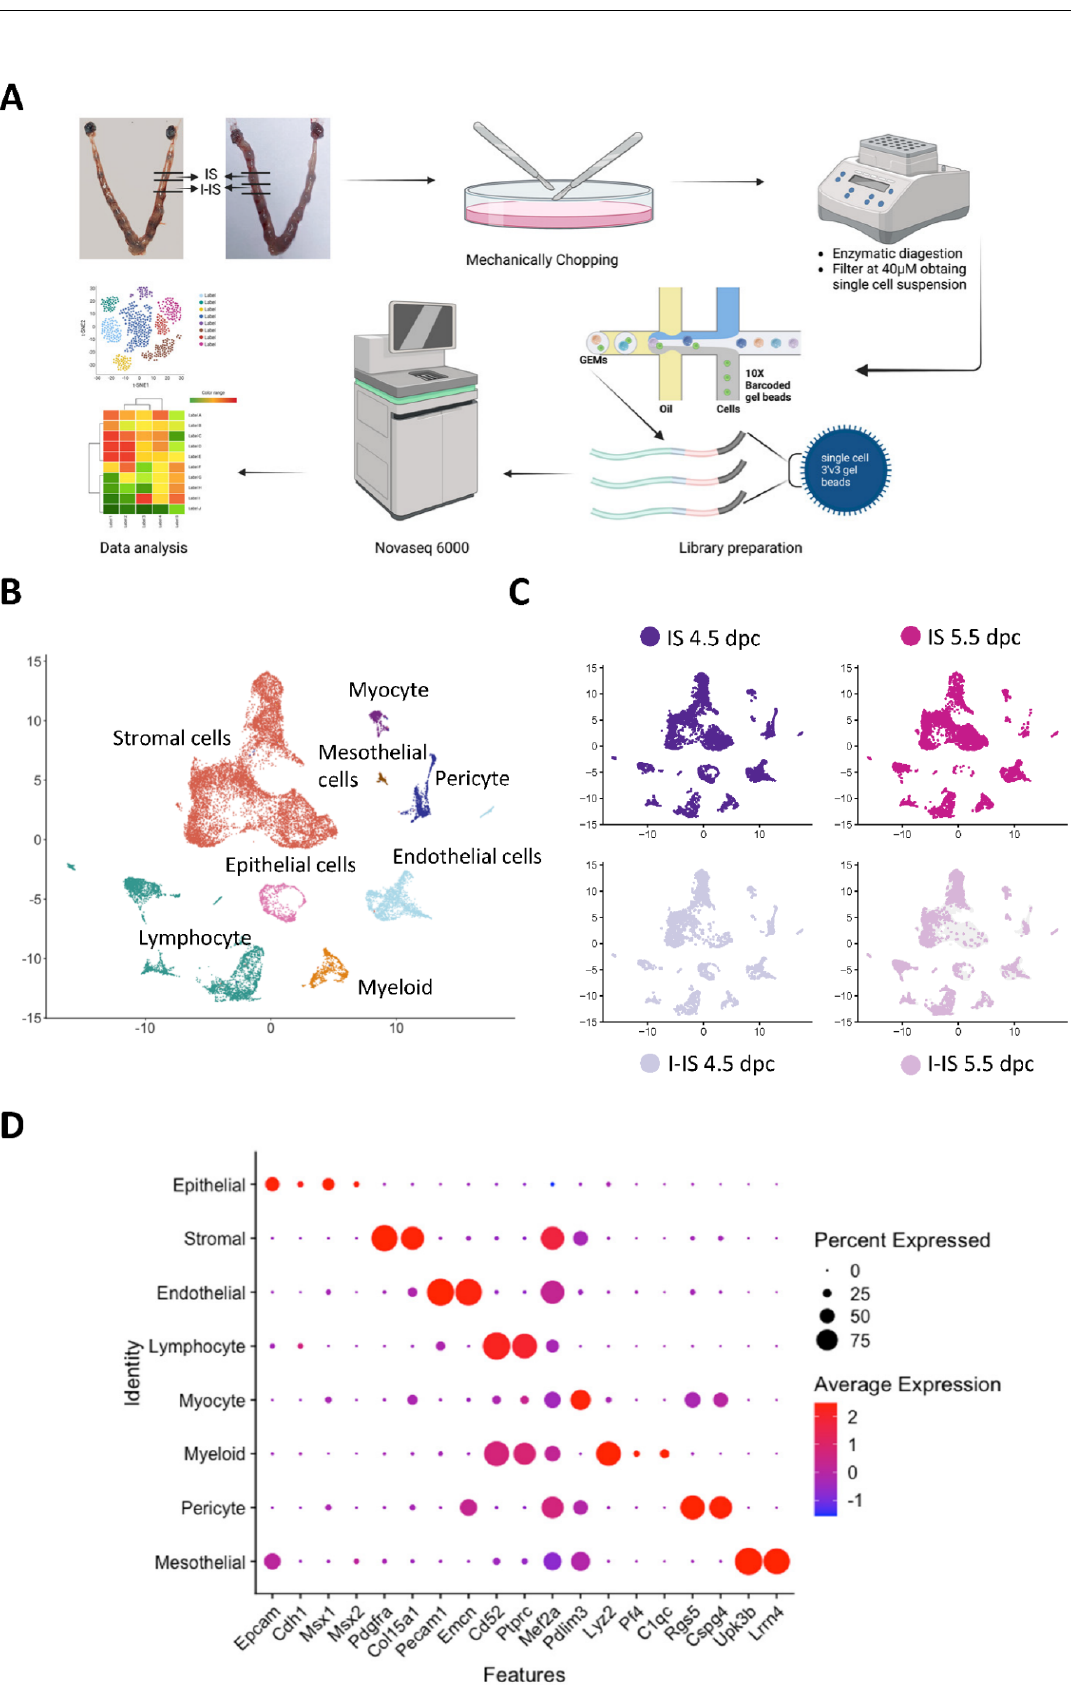
Figure 1. Single-cell RNA sequencing (scRNA-seq) of pregnant mice uteruses at 4.5 and 5.5